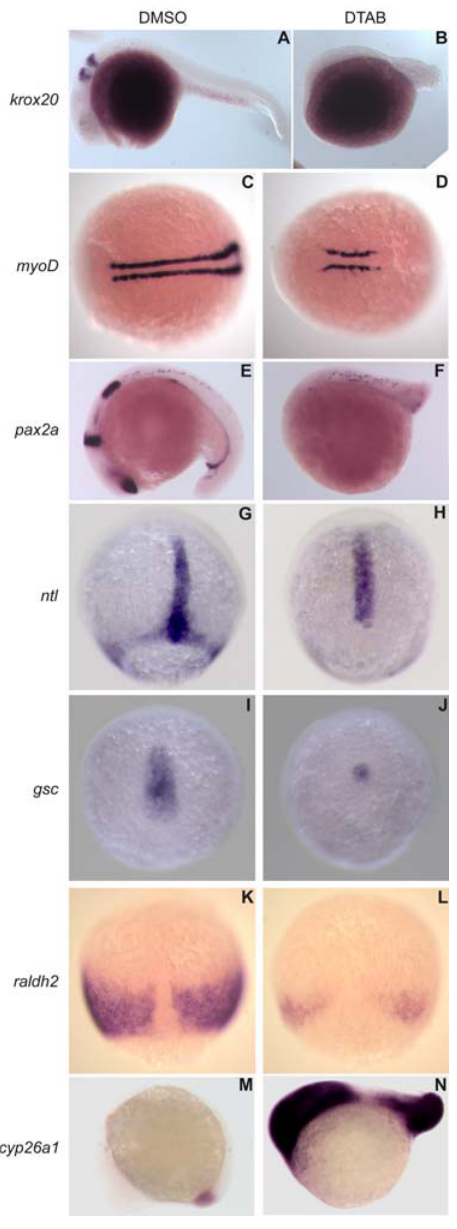
Figure 3. DTAB affects the expression of early developmental markers. In situ hybridizations of zebrafish embryos show that treatment with DTAB results in severe reduction of krox20 , pax2a , myoD , ntl , gsc , and raldh2 staining. DTAB treated embryos exhibited an upregulation of cyp26a1 transcripts in the tail and head. Embryos were treated with 12.5 m M DTAB or DMSO control from 4hpf onwards until fixation. Embryos were fixed at 75% epiboly (G–L), 10-somite (M–N), 18-somite (C–F) and 26-somite (A,B) stages. A–B, E–F, M–N are lateral views with anterior to the left and dorsal to the top. C–D are dorsal views with anterior to the left. G–L are dorsal views with the animal pole to the top.